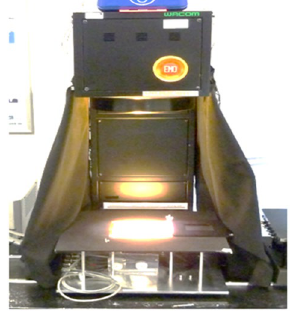
Figure 4. PVcomB solar simulator.